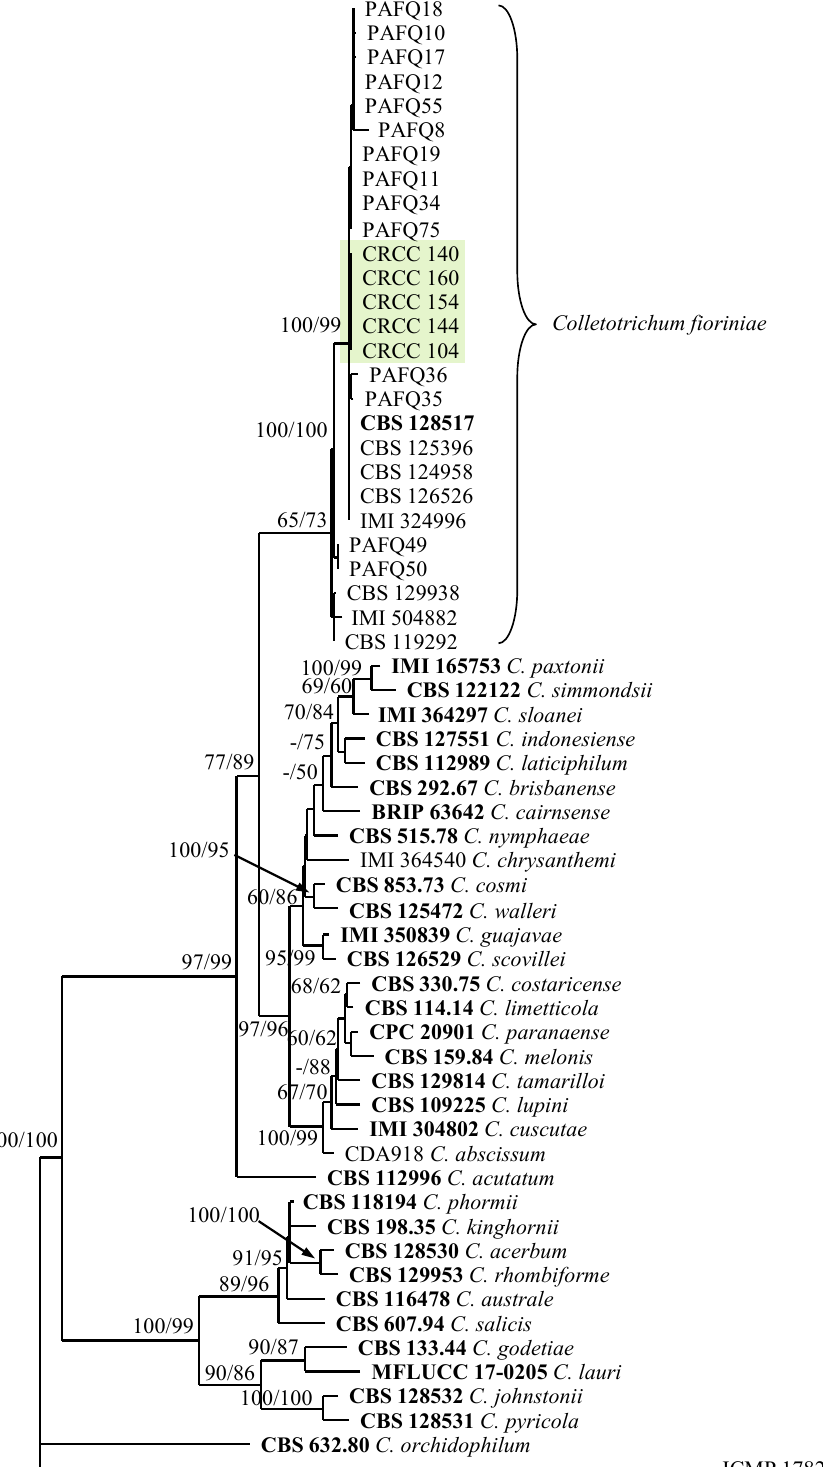
Figure 5. One of the most parsimonious trees obtained from the combined alignment of the ITS, gapdh , chs-1 , act and tub sequence data- sets of Colletotrichum isolates, with bootstrap support values from maximum parsimony/maximum likelihood analyses. Isolates obtained in this study are indicated by green rectangles. Ex-type sequences are indicated in bold. Colletotrichum orchidophilum and C. gloeosporioides were used as